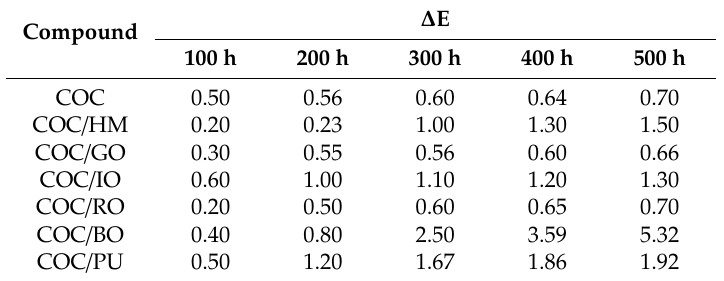
Table A1. Total color change ( ∆ E) parameter of samples exposed to different aging times.